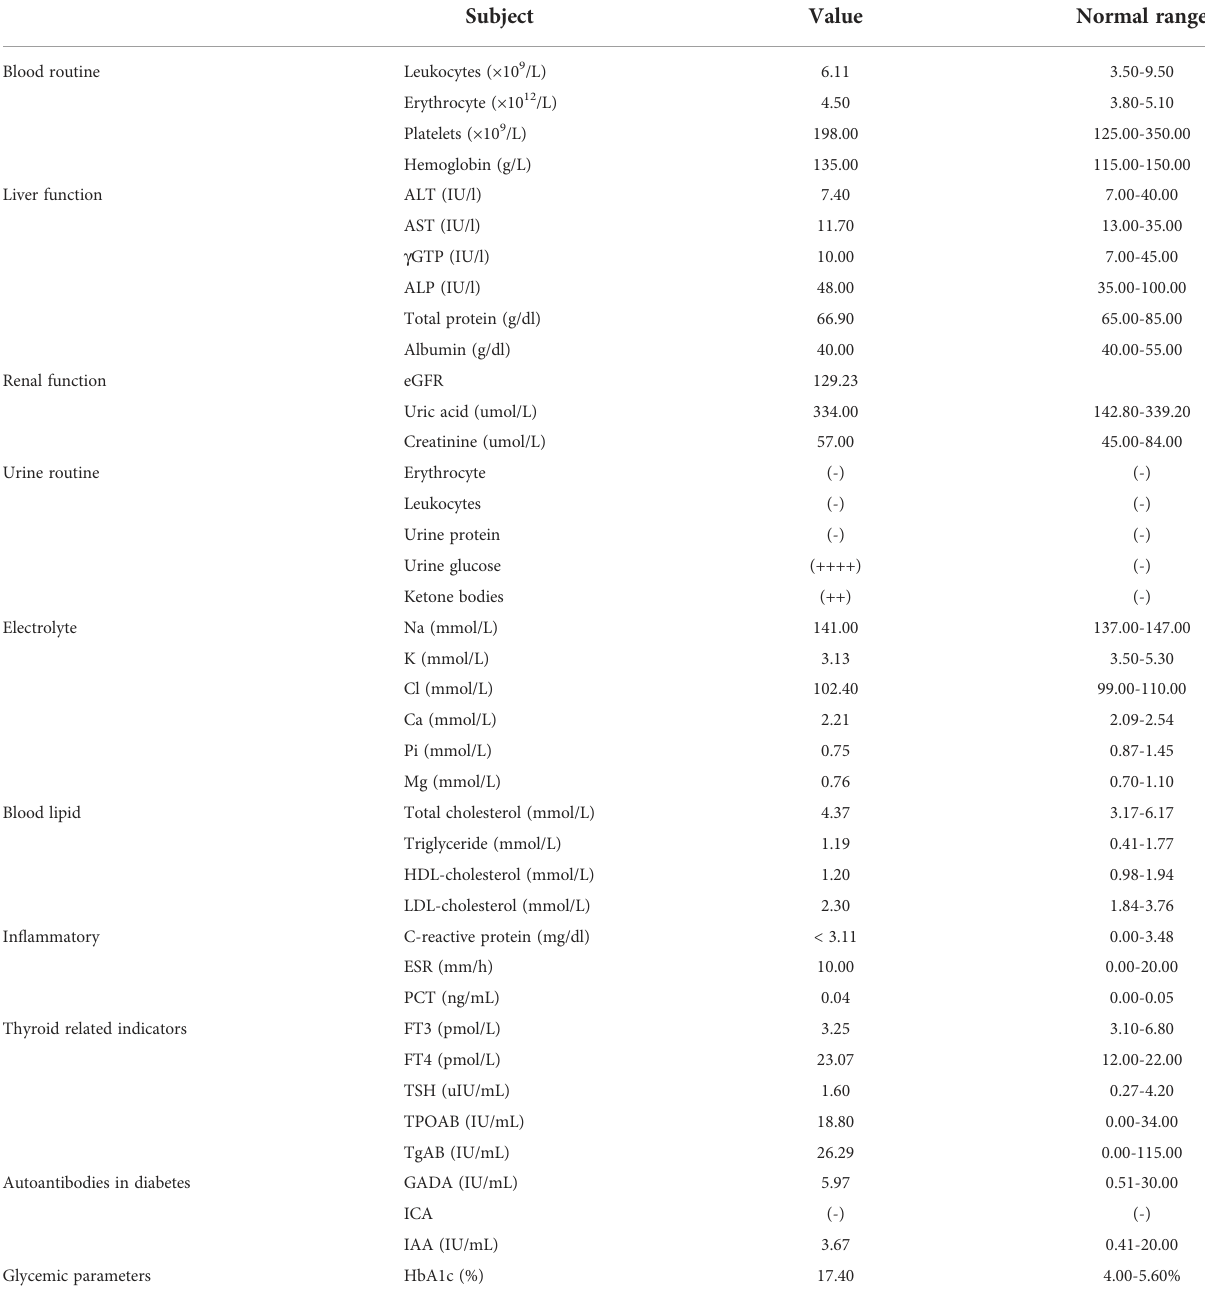
TABLE 1 Laboratory examinations at the time of